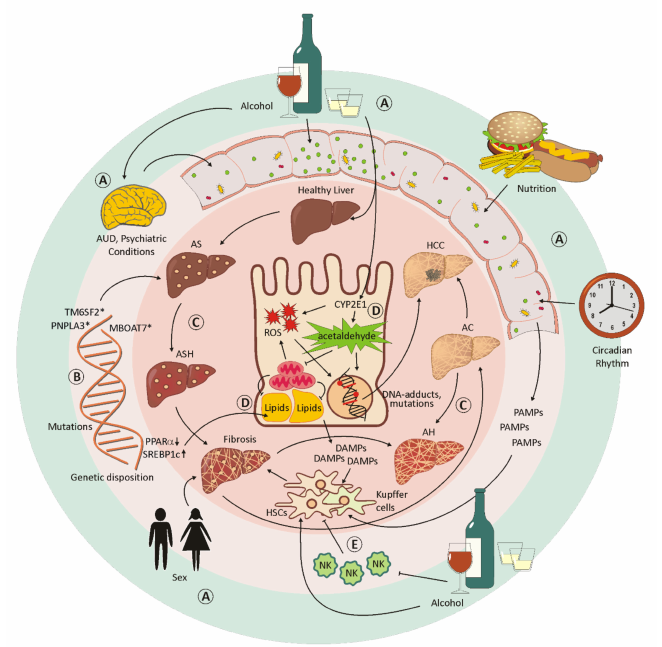
Figure 2. Impact of alcohol overconsumption on hepatic processes. ( A ) Chronic alcohol